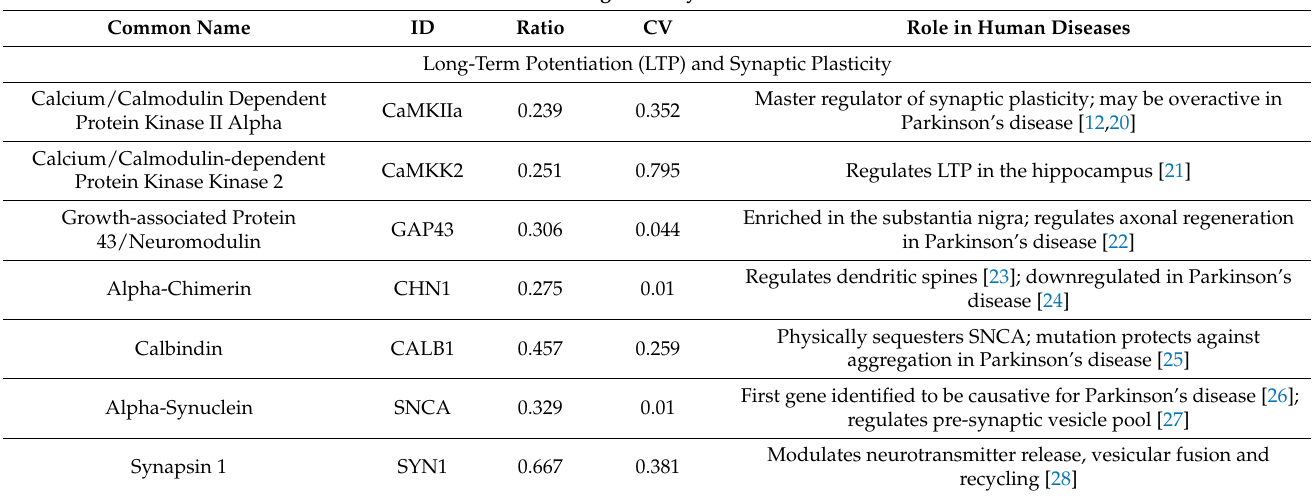
Table 1. A manually curated shortlist of the top-ranked proteins that are downregulated when PHF8 is knocked down in activated neurons showing a functional enrichment of synaptic plasticity and Parkinson’s disease. The full set of hits can be found in Supplementary Table S1. The genes encoding for the proteins that are in bold are known to be potential target genes of PHF8 as per the ChIP-Atlas